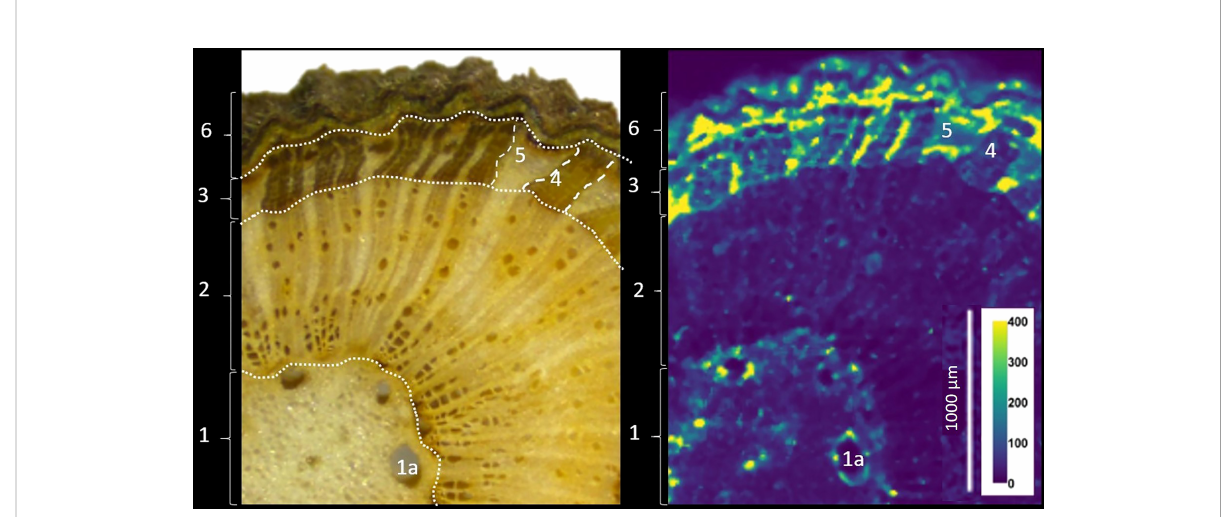
FIGURE 6 (Left) Microscope image of the branch section, and LA-ICP-MS image for Cd. The intensity is expressed in total counts (cts). From inside to outside: 1: Medulla/pith, including the secretory vessels (1a). 2: wood. 3 to 6: bark, including the phloem part (3) with phloem vessels (4) and phloem rays (5), and the periderm (6), composed of phelloderm and cork. (Right) Map of Cd counts (cts). Cadmium is particularly abundant in the phloem rays (5) and periderm